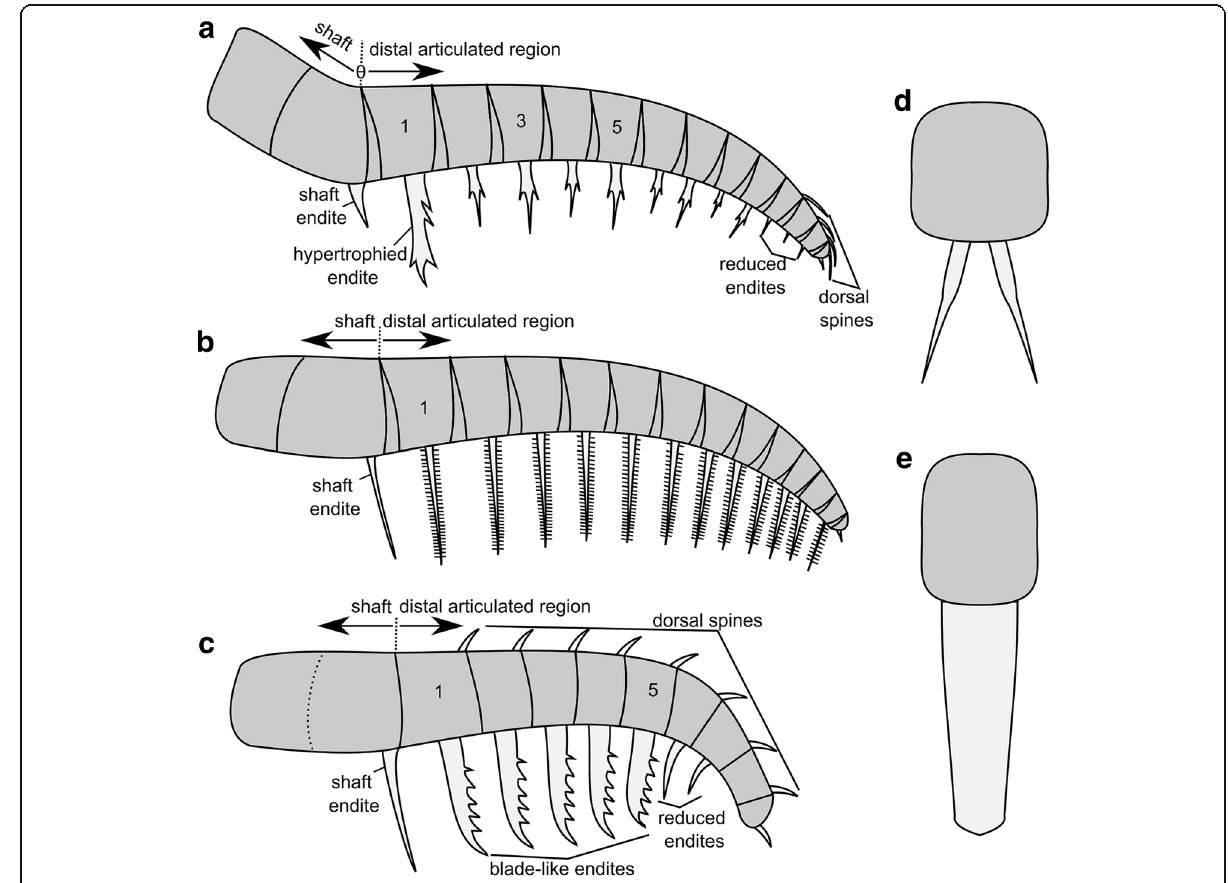
Fig. 1 Schematic organisation of frontal appendages of different radiodont families. a Amplectobeluidae and Anomalocarididae. One marks first podomere in distal articulated region, bearing hypertrophied endite. Five marks podomere where endite is longer than on podomere 3 in Amplectobeluidae, but not Anomalocarididae. b Tamisiocarididae. One marks first podomere in distal articulated region. c Hurdiidae. One marks first podomere in distal articulated region, 5 marks most distal podomere bearing elongate endite. d Attachment of paired endites to podomere in Amplectobeluidae, Anomalocarididae, and Tamisiocarididae (cross-sectional view). e Single blade-like endite attached to podomere in Hurdiidae (cross-sectional